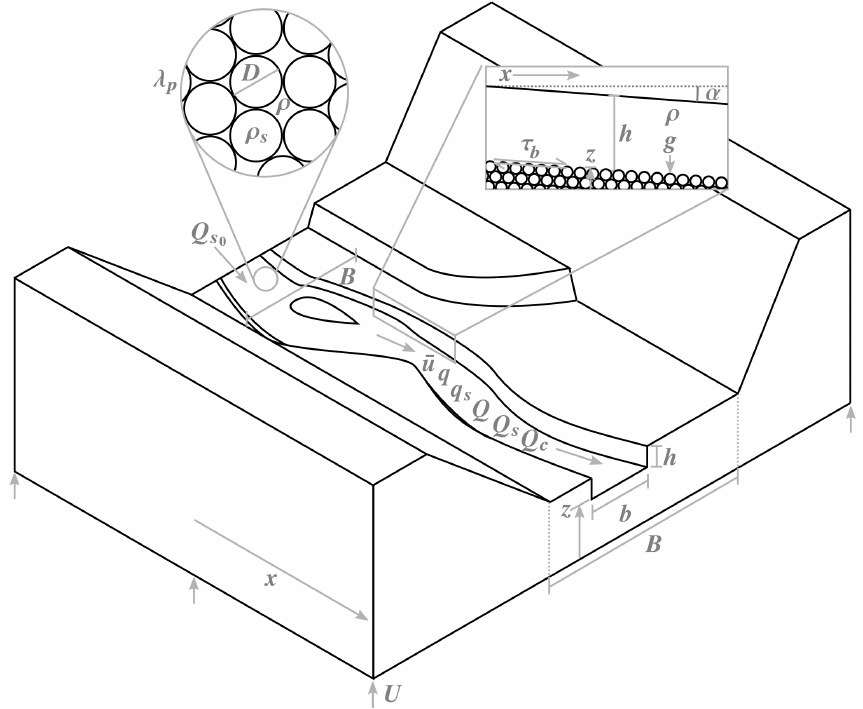
Figure 1. Schematic block diagram of sediment transport through a reach of a transport-limited river. Variables are defined in the text and in Appendix A. The balance of sediment input, sediment output, and uplift determine whether the river bed at each point downstream will rise, fall, or remain at a constant